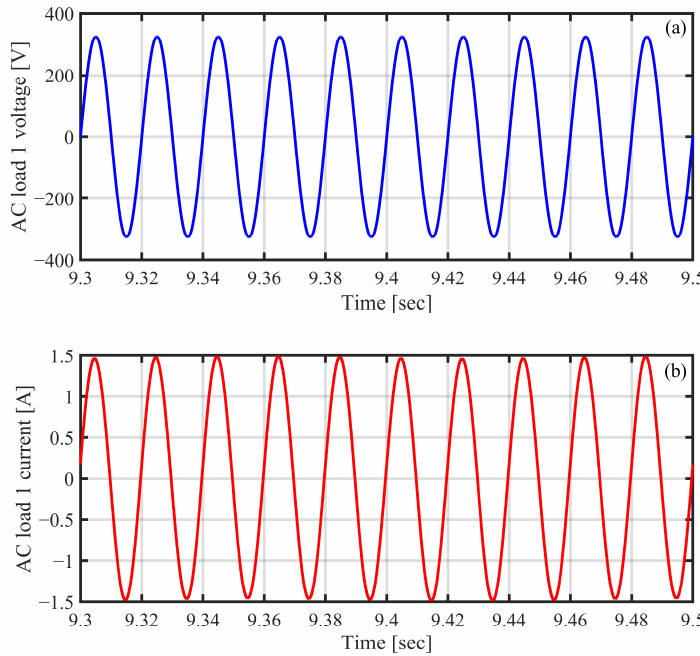
Figure 24. AC load 1 voltage ( a ) and current ( b ) values in the LVAC distribution under OCF.